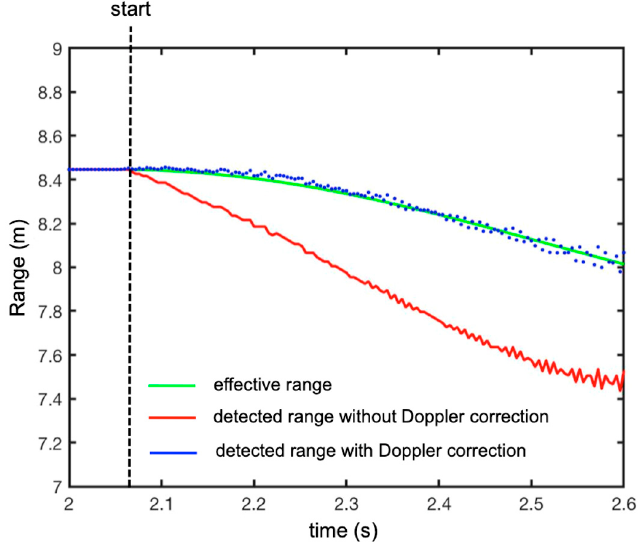
Figure 12. Time-range map of the measured IFFT (experimental set-up shown in Figure 8).